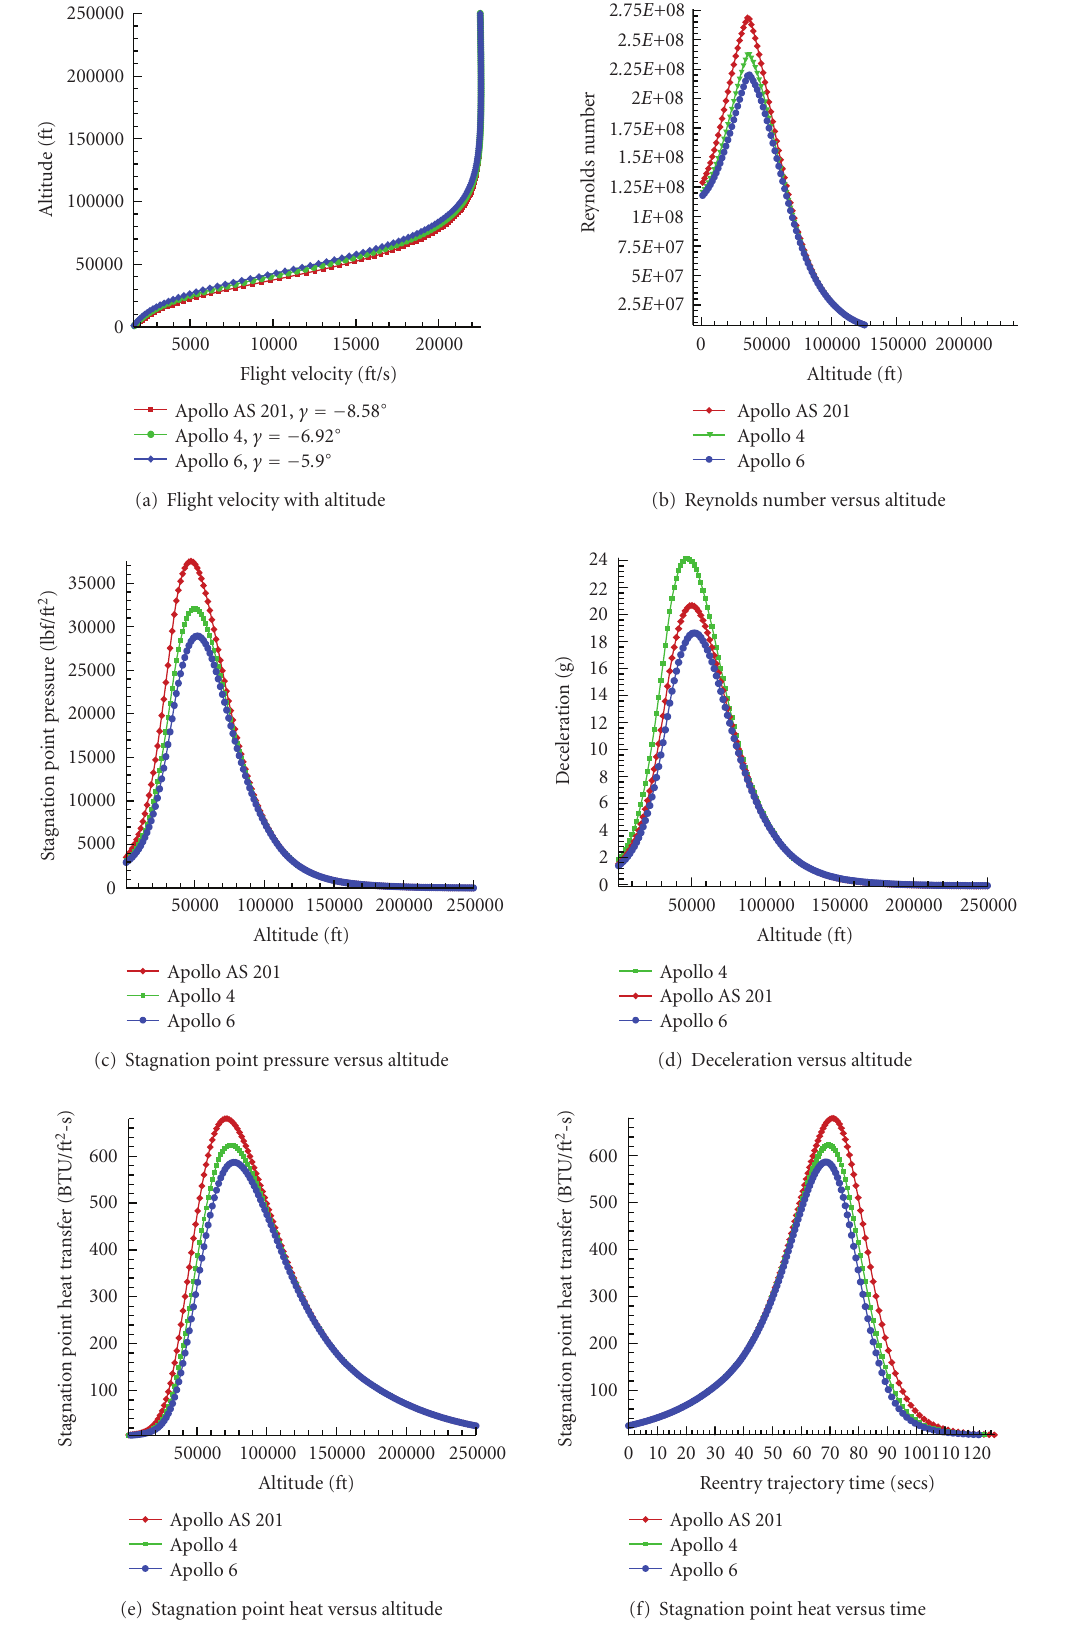
Figure 15: (a)–(f) Trajectory data: flight velocity, stagnation point heating, deceleration versus